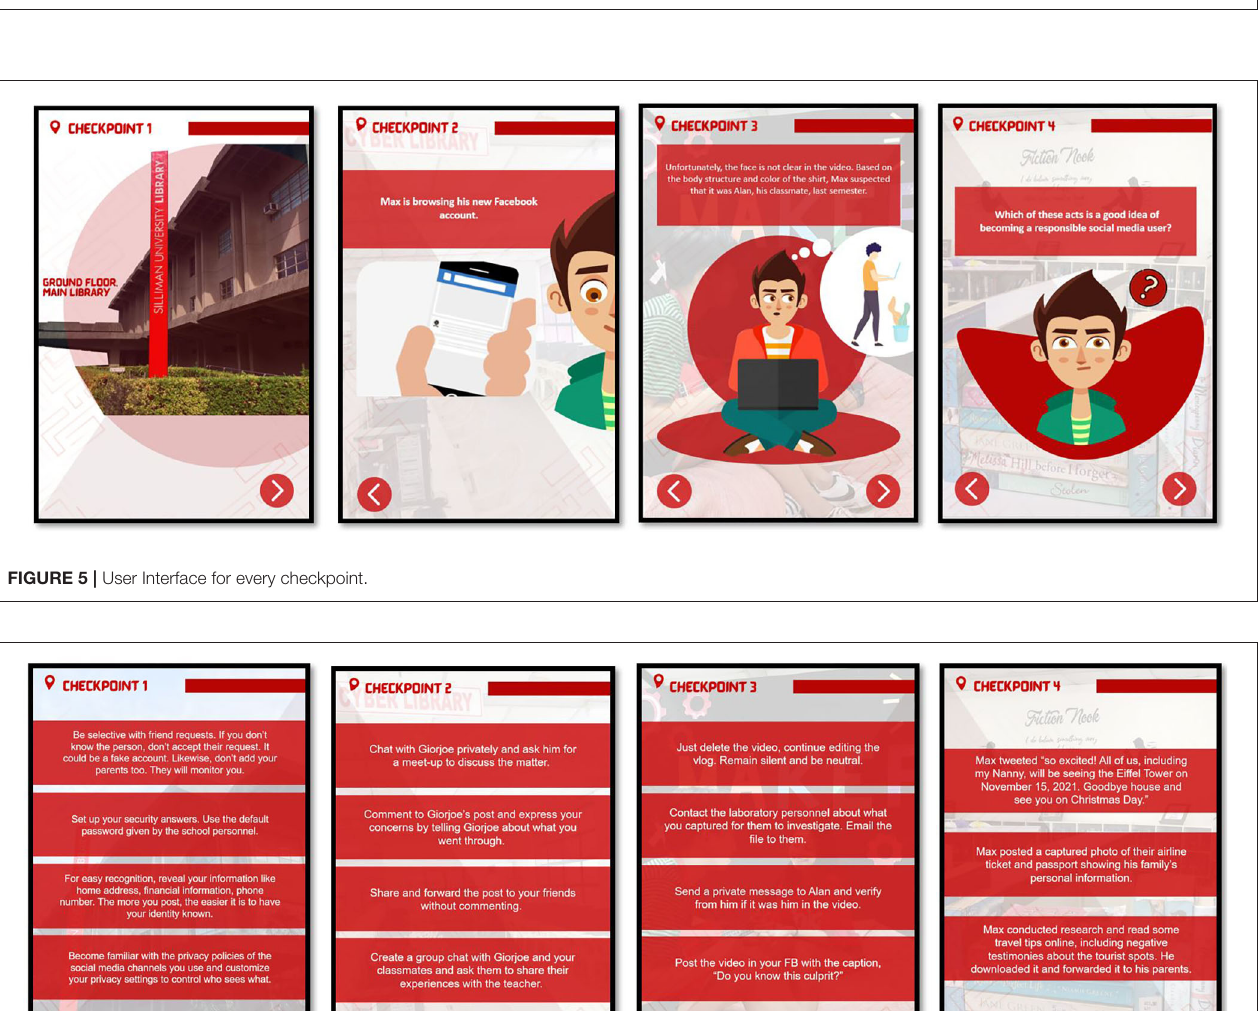
FIGURE 4 | Prototyping.